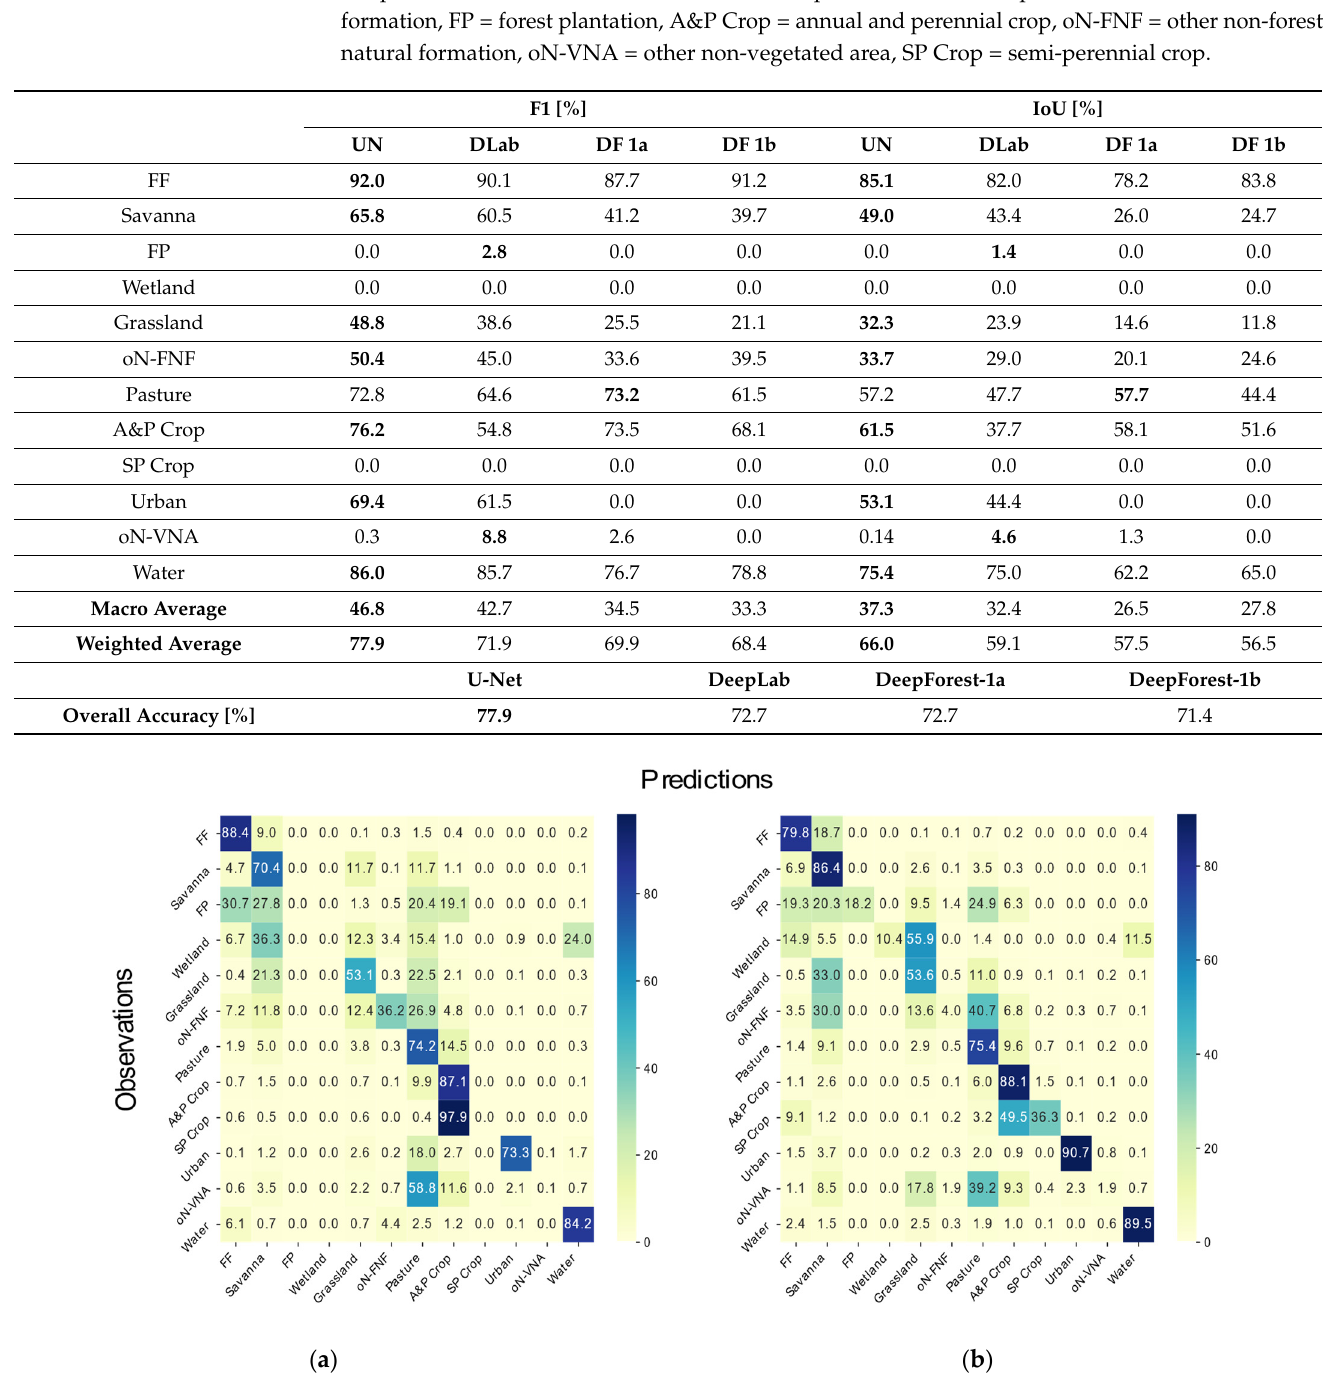
Table 3. Test accuracies of the classifications based on multispectral data (S2 dataset) for SotA and DeepForest-1 models. Abbreviations: DF = DeepForest, DLab = DeepLab, UN = U-Net, FF = forest